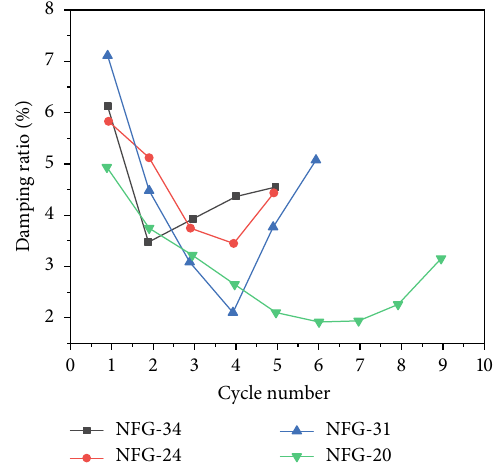
Figure 12: Evolution of dynamic elastic modulus with cycle number.